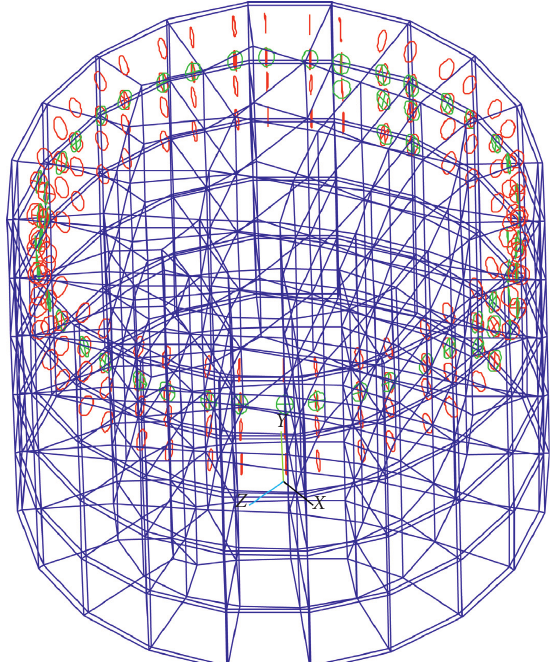
Figure 23: Spherical hinge cracking diagram